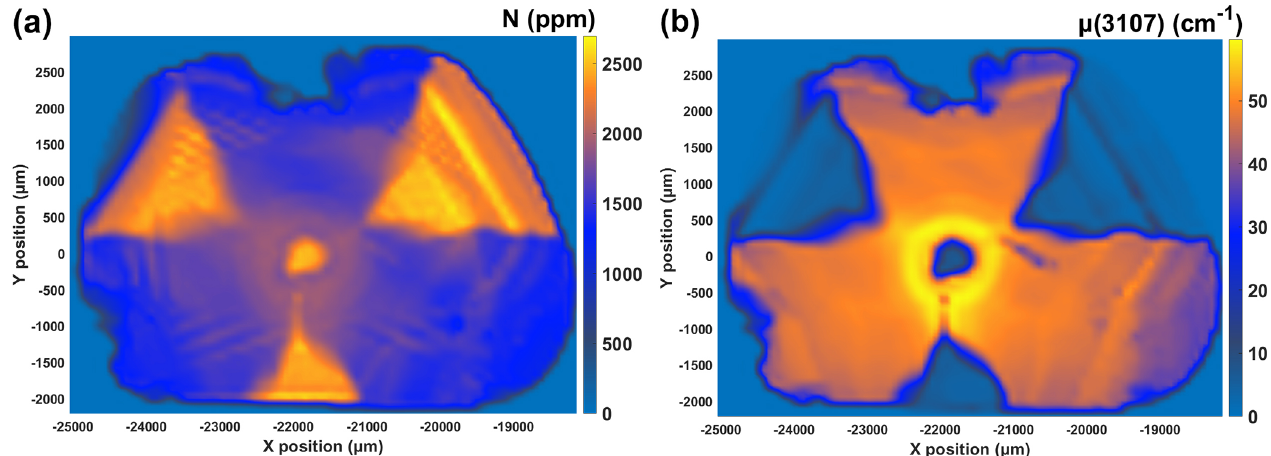
Figure 7. The maps of the (a) nitrogen concentration and (b) absorption coefficients of the 3107cm − 1 peak in